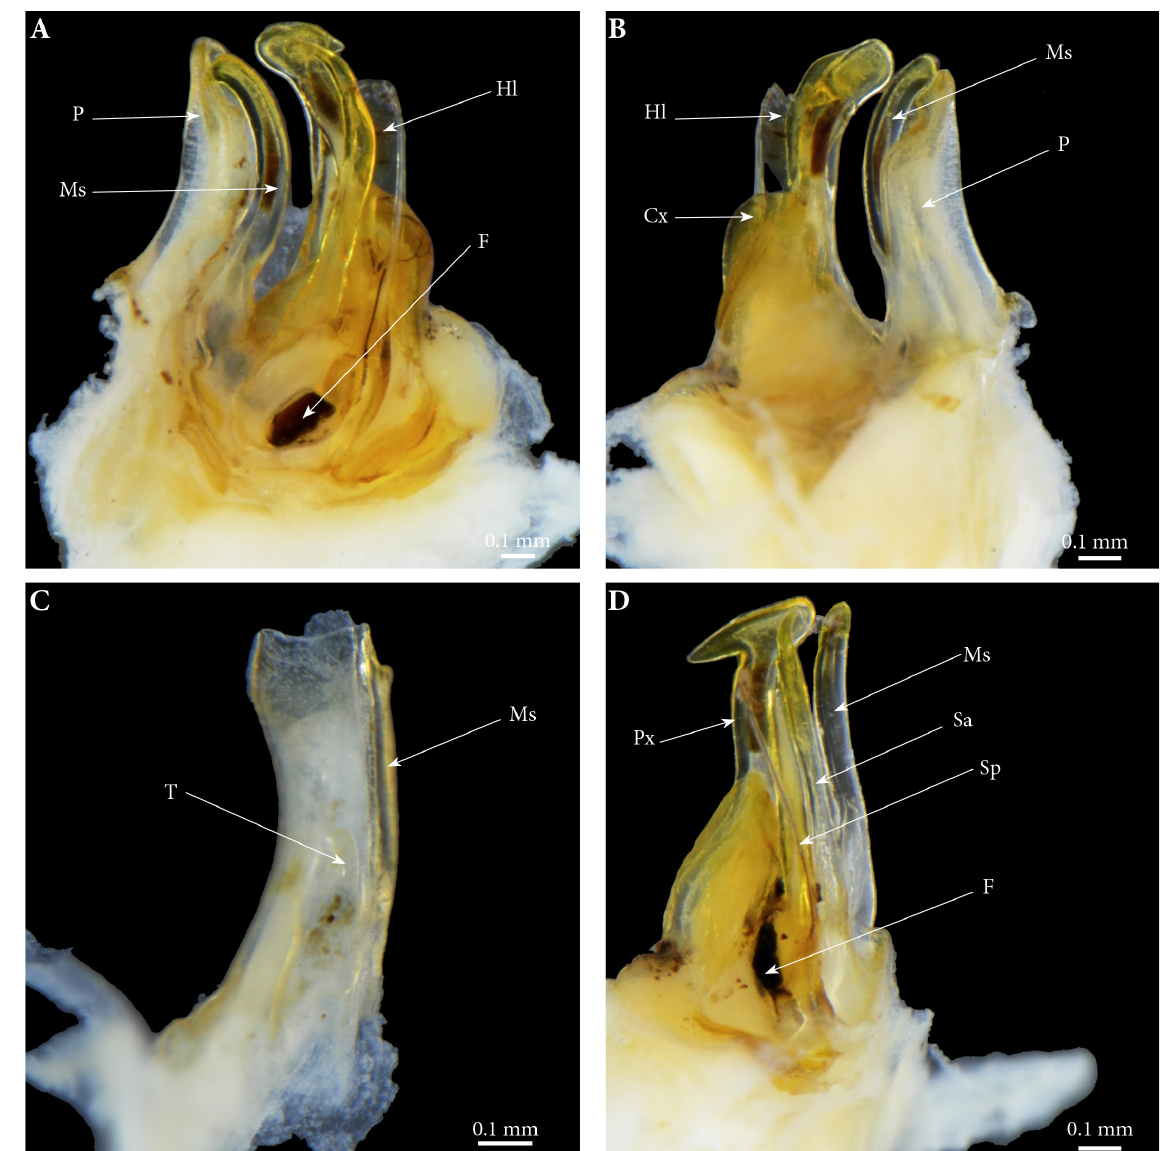
Fig. 13. Ommatoiulus litoralis sp. nov. Paratype, ♂ from Algarve, gonopods. A . Left gonopod, mesal view. B . Left gonopod, lateral view. C . Right promerite, posterior view. D . Right posterior gonopod, postero-mesal